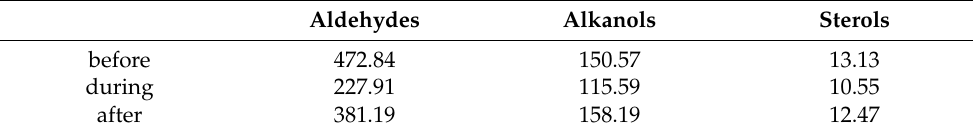
Table 2. Total average concentration of aldehydes, alkanols, and sterols in three time periods (ng/m 3